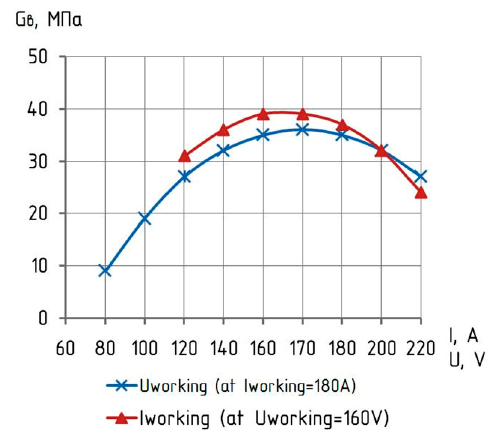
Figure 8. Influence of spraying modes on adhesive properties: × —U working (at I working = 180A); ∆ —I working (at U working = 160 V).